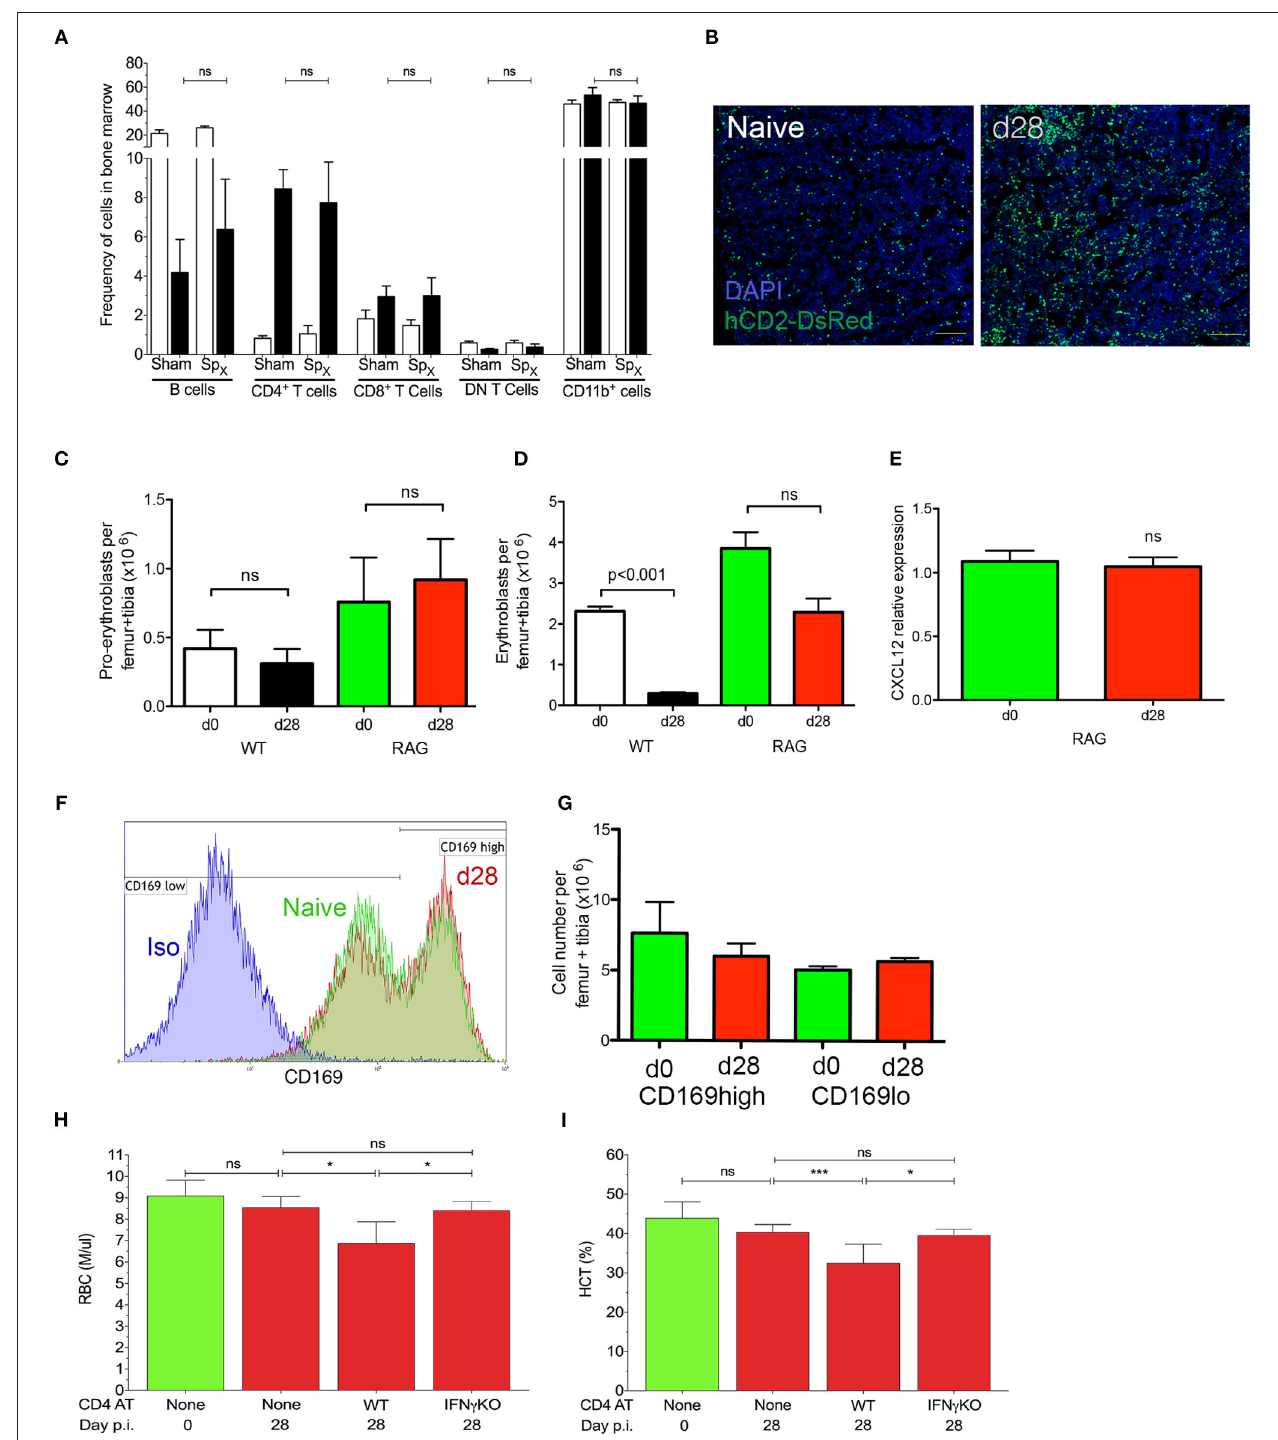
FIGURE 5 | IFN γ -producing CD4 + T cells mediate repression of medullary erythropoiesis in experimental VL. (A) Frequency of leucocyte subsets accumulating in the BM of sham-operated or Sp x naïve (open bars) and infected (black bars) mice. Data from one experiment ( n = 5) mice per group; Mann-Whitney: not significant (ns). (B) T cell accumulation in BM visualized using hCD2-DsRed mice. Sectioned were counterstained with DAPI (blue). Femurs representative of 15 mice per group examined from three independent experiments. (C,D) Absolute numbers of pro-erythroblasts (C) and erythroblasts (D) in the BM of naïve and infected wild type C57BL/6 or B6. Rag2 − / − mice. Absolute numbers were calculated by multiplying frequencies by the total BM cell counts (One-way ANOVA with Turkey’s multiple